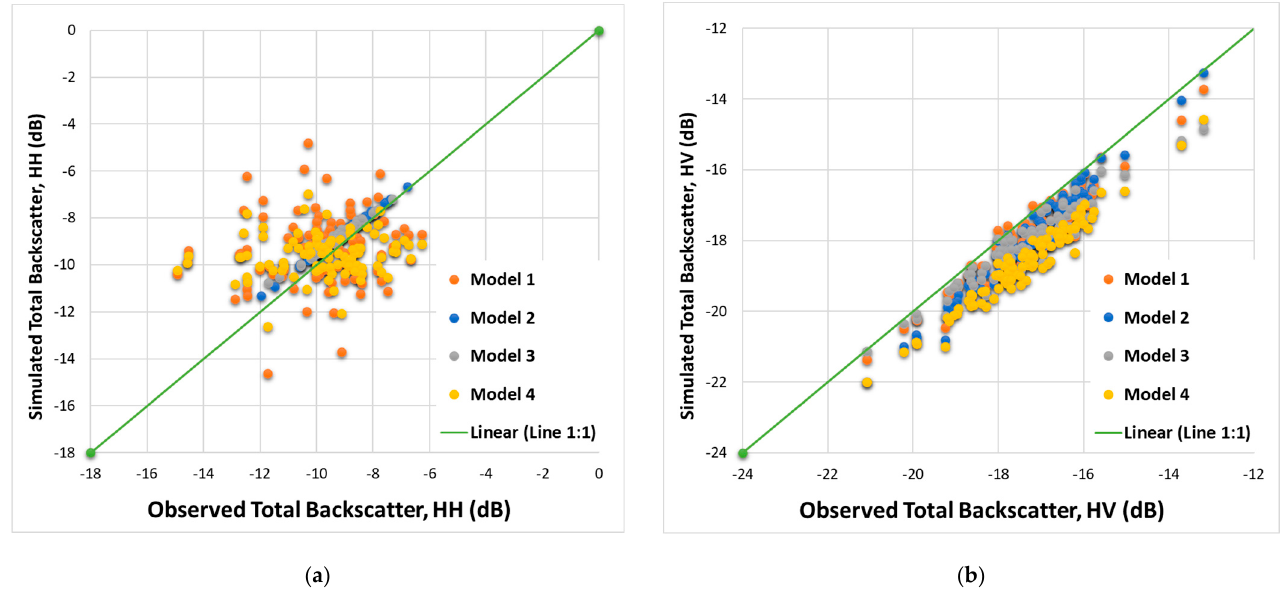
Figure 2. Scatterplots showing the simulated and observed backscatter coefficients under ( a ) HH and ( b ) HV polarization.